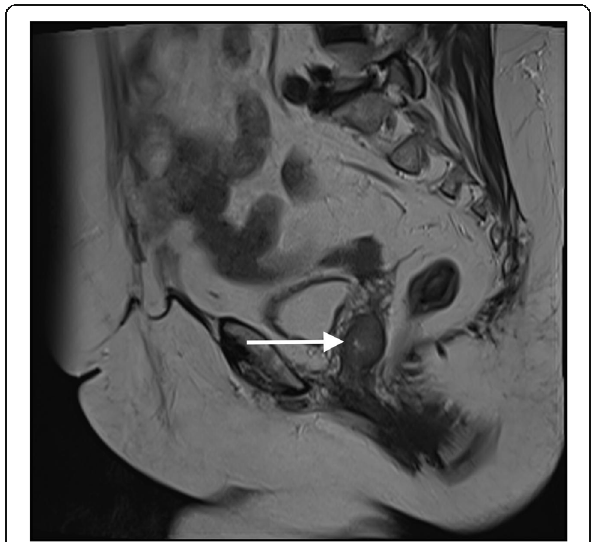
Fig. 2 Sagittal T2-weighted image demonstrates lesion (arrow) with intermediate T2 signal intensity filling vaginal